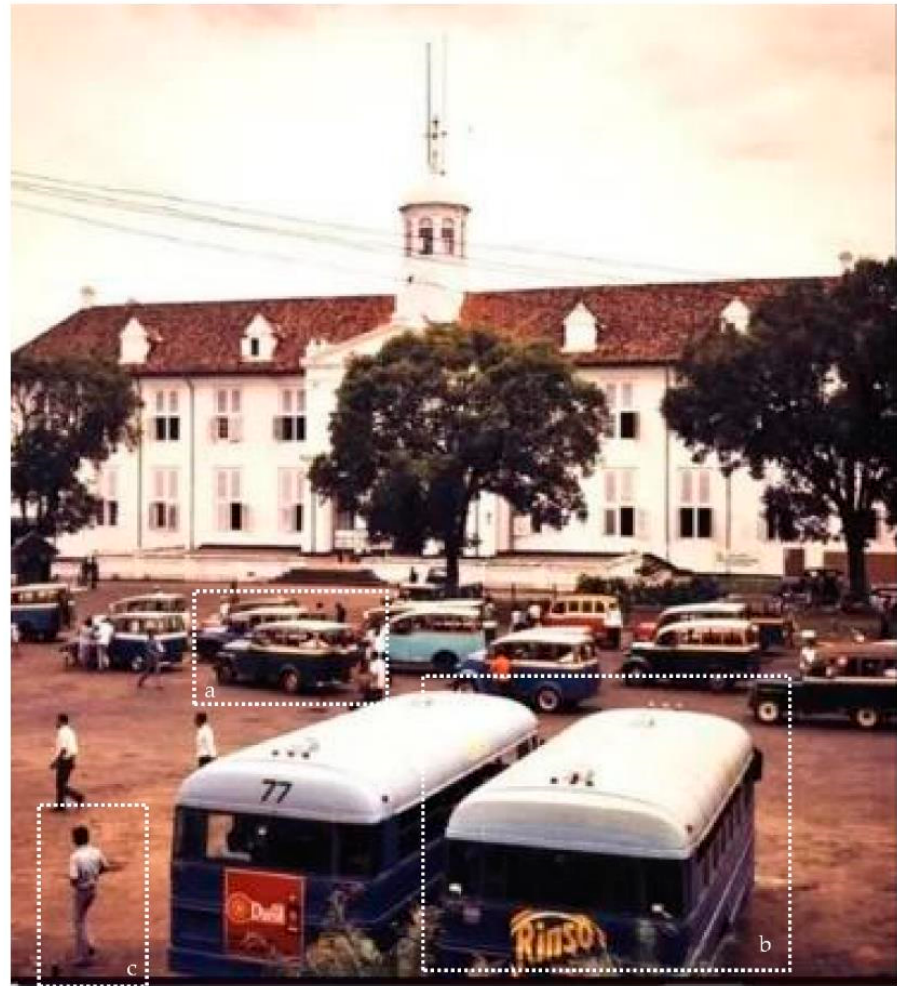
Figure 12. The situation of Fatahillah Square as the bus terminal in 1971. Identified sound sources: ( a ) Microbuses ( b ) Buses ( c ) human. Source: Collection of Tropenmuseum.